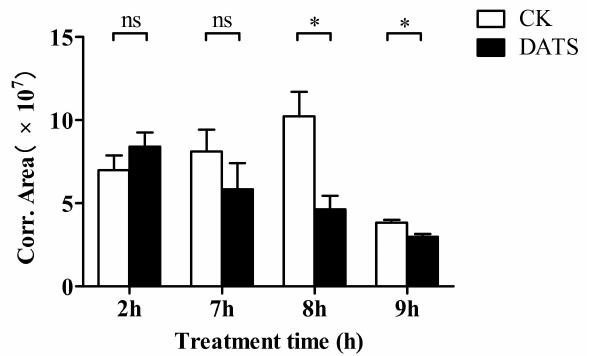
Figure 6. The e ff ect of diallyl trisulfide (DATS) on the amount of sex pheromone secreted by female Sitotroga cerealella compared to the control (CK). * Indicates significance at p < 0.05, while ns indicates no significant di ff erence ( t